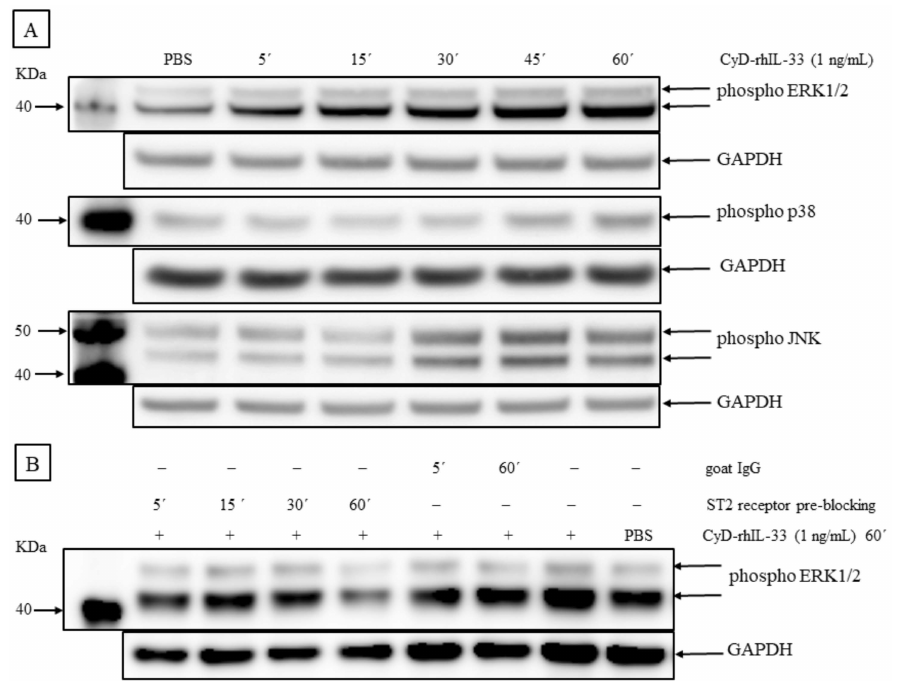
Figure 9. IL-33 upregulates MAP kinase activity. ( A ) Phosphorylation levels of ERK1/2, p38, and JNK were determined by western blot analysis using phospho-specific antibodies to detect Thr202/Tyr204 (ERK1/2), Thr183/Tyr185 (JNK), and Thr180/Tyr182 (p38) phosphorylation, when compared to GAPDH. MCC-13 cells were serum-starved for 24 h, and thereafter stimulated with either vehicle (PBS) or 1 ng/mL of CyD-rhIL-33 for different time points (5 (cid:48) , 15 (cid:48) , 30 (cid:48) , 45 (cid:48) , and 60 (cid:48) ). ( B ) The blockade of the ST2 receptor interferes with IL-33-induced activation of ERK1/2 activity. Phospho ERK1/2 levels were determined by western blot. MCC-13 cells were serum starved for 24 h. The cells were pre-blocked with goat anti-ST2 antibody (2 ng/mL) for a varying time duration of 5–60 min or with polyclonal normal goat IgG for 5 or 60 min. The cells were then stimulated with CyD-rhIL-33 (1 ng/mL) in the presence of, or without a ST2 receptor antibody, for 60 min. PBS was used as a vehicle